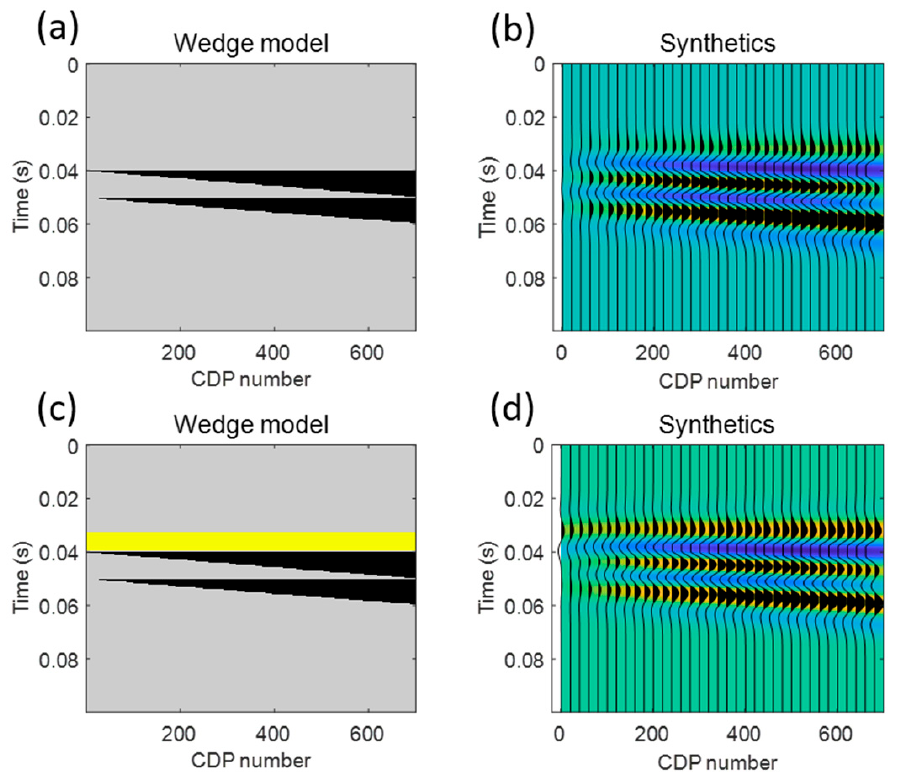
Figure 1. Double-layer wedge model comprising a pure coal seam and sandstone and its forward seismic records: ( a ) coal model, ( b ) coal synthetic, ( c ) sand–coal model, and ( d ) sand–coal synthetic. The following different sand–coal combination models are constructed based on the lithological interpretation results of actual logging data. The time of the model starts at approximately 5000 m. In the seven models constructed below, for the single-well model diagram, yellow represents sandstone, black represents coal, and grey represents